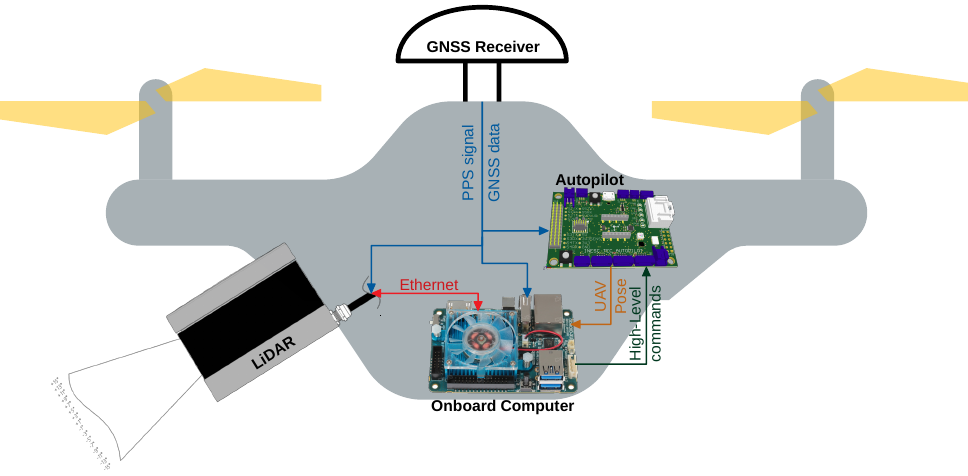
Figure 1. High-level hardware